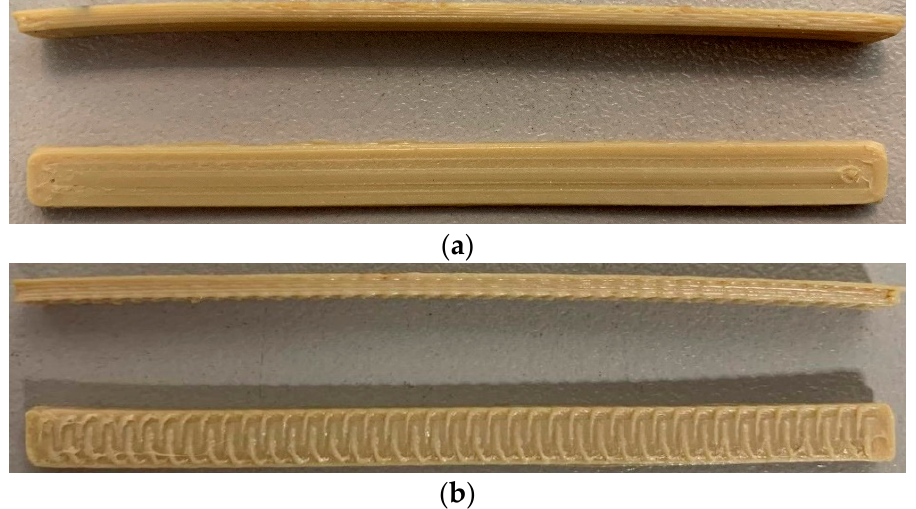
Figure 14. General view (side and top) of the resulting product with the layout: ( a ) along; ( b ) across the long side.